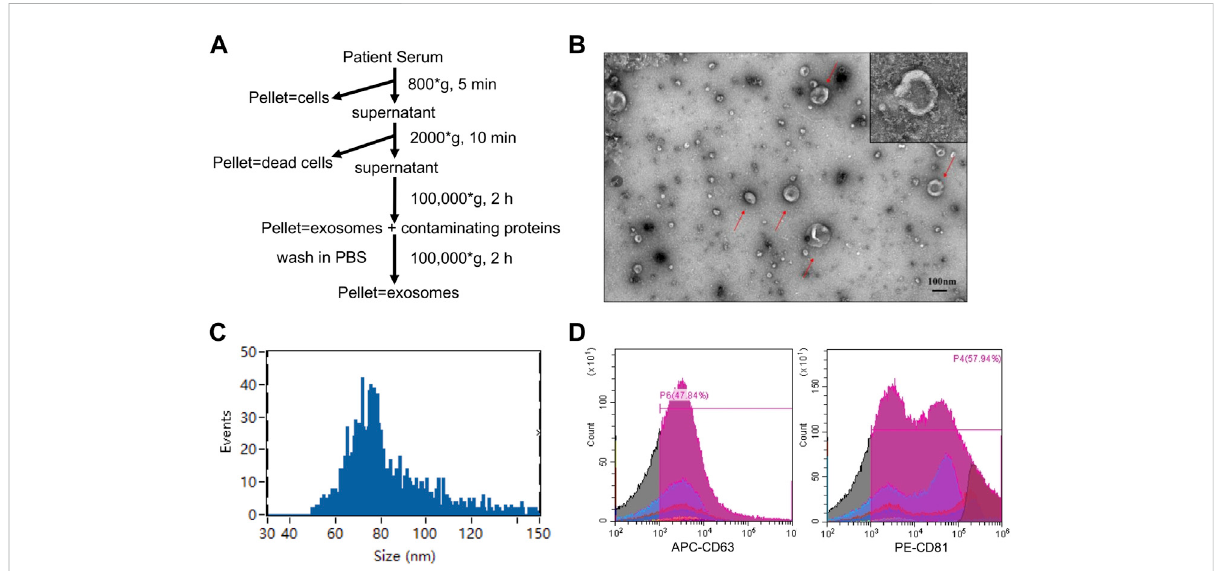
FIGURE 2 CharacterizationofEVs. (A) TheproceduresforEVsisolationusedinthisstudy. (B) MorphologicalcharacterizationofEVsisolatedfromserumby transmission electron microscopy. Typical EVs were ampli fi ed with red arrows. Scale bar = 100 nm (upper). (C) Average size distribution of EVs was revealed by nanoparticle tracking analysis. (D) EVs protein markers (CD 63 and CD 81) were identi fi ed by fl ow cytometry.